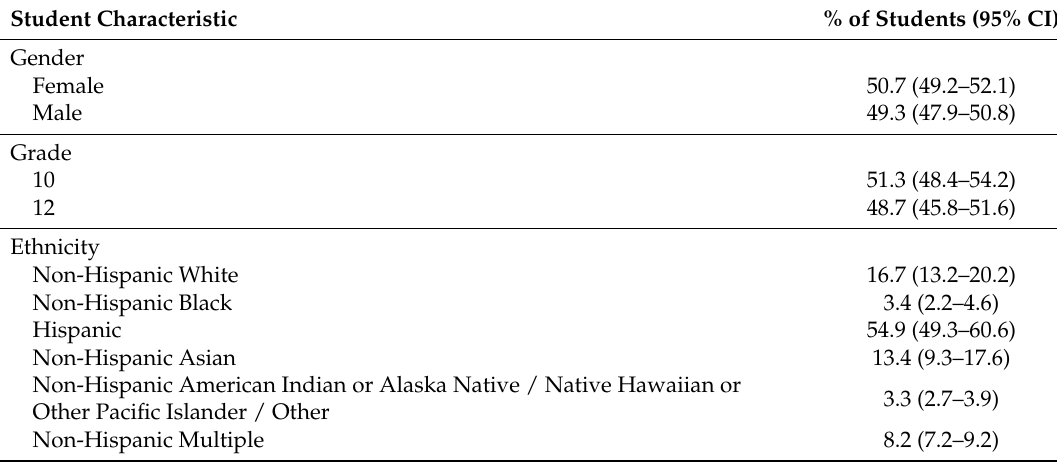
Table 1. Weighted demographic characteristics of the sample of high school students, 2015–16 California Student Tobacco Survey ( n =